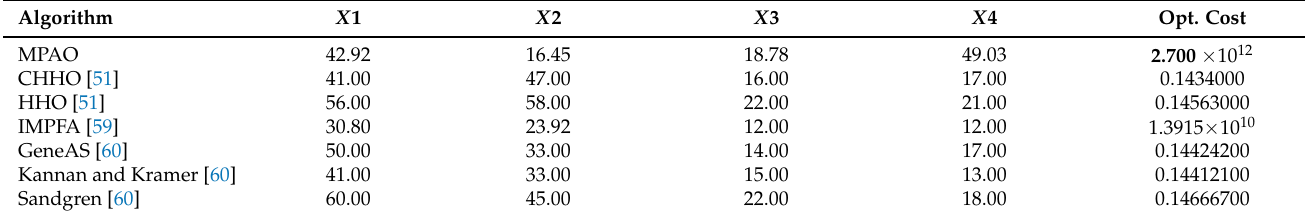
Table 18. Results of the gear train design